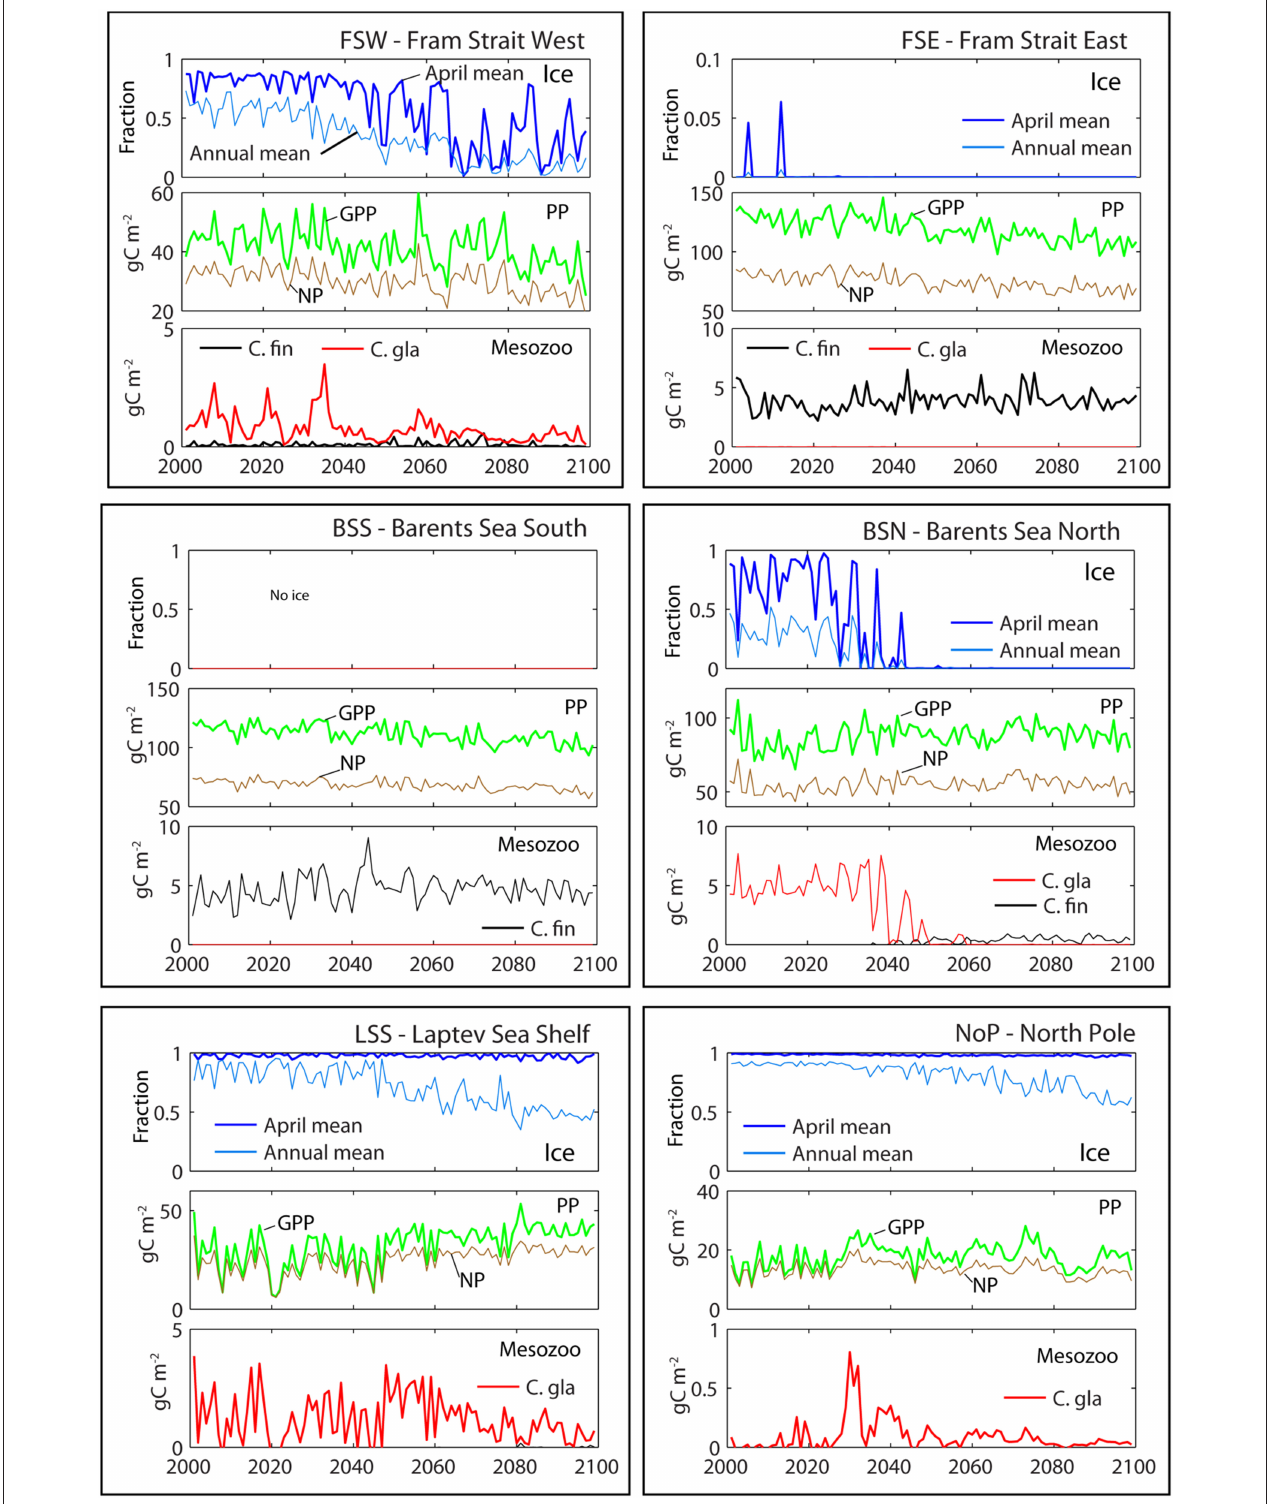
FIGURE 7 | Time series variation at six stations in the Arctic Ocean. FSW, Fram Strait West; FSE, Fram Strait East; BSS, Barents Sea South; BSN, Barents Sea North; LSS, Laptev Sea Shelf Break; and NoP, North Pole (see Figure 2 ). Each of the six boxes shows the fraction of ice cover (above, 0–1), gross primary production (GPP, red) and new production (NP, blue) (middle; g C m − 2 y − 1 ) and the production of Calanus finmarchicus (C. fin., black) and Calanus glacialis (C. gla., red) (g C m − 2 y − 1 ). Forced by a A1B scenario.